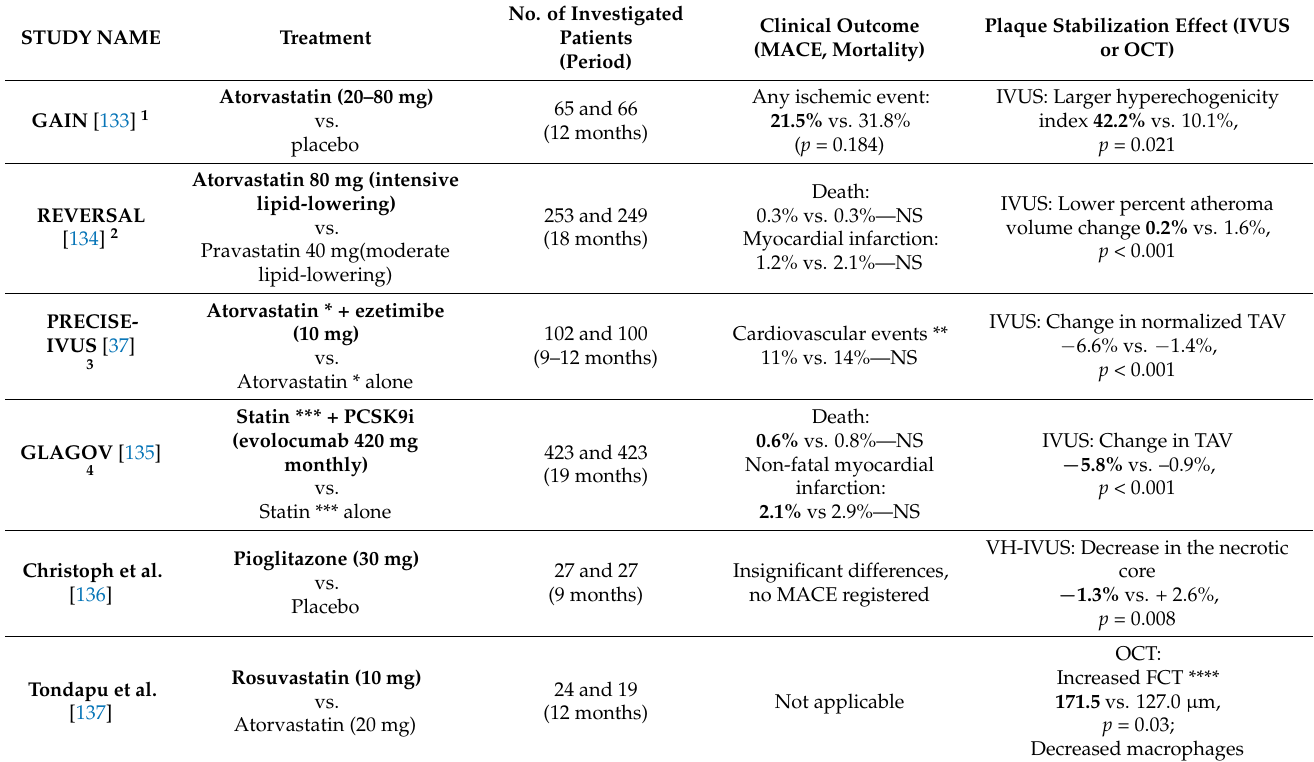
Table 2. Clinical studies with outcomes referring to atherosclerotic plaque stabilization visualized with imaging methods (IVUS or